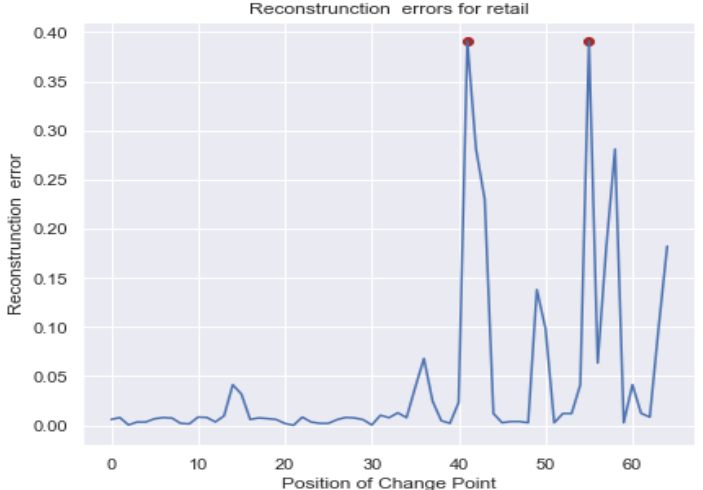
Figure 4. Reconstruction errors for grocery and